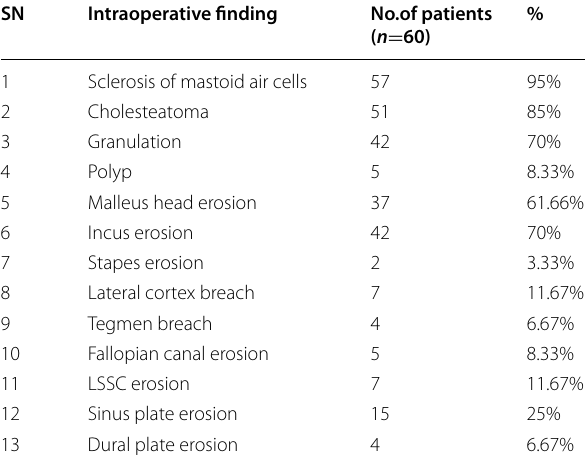
Table 2 Intra-operative